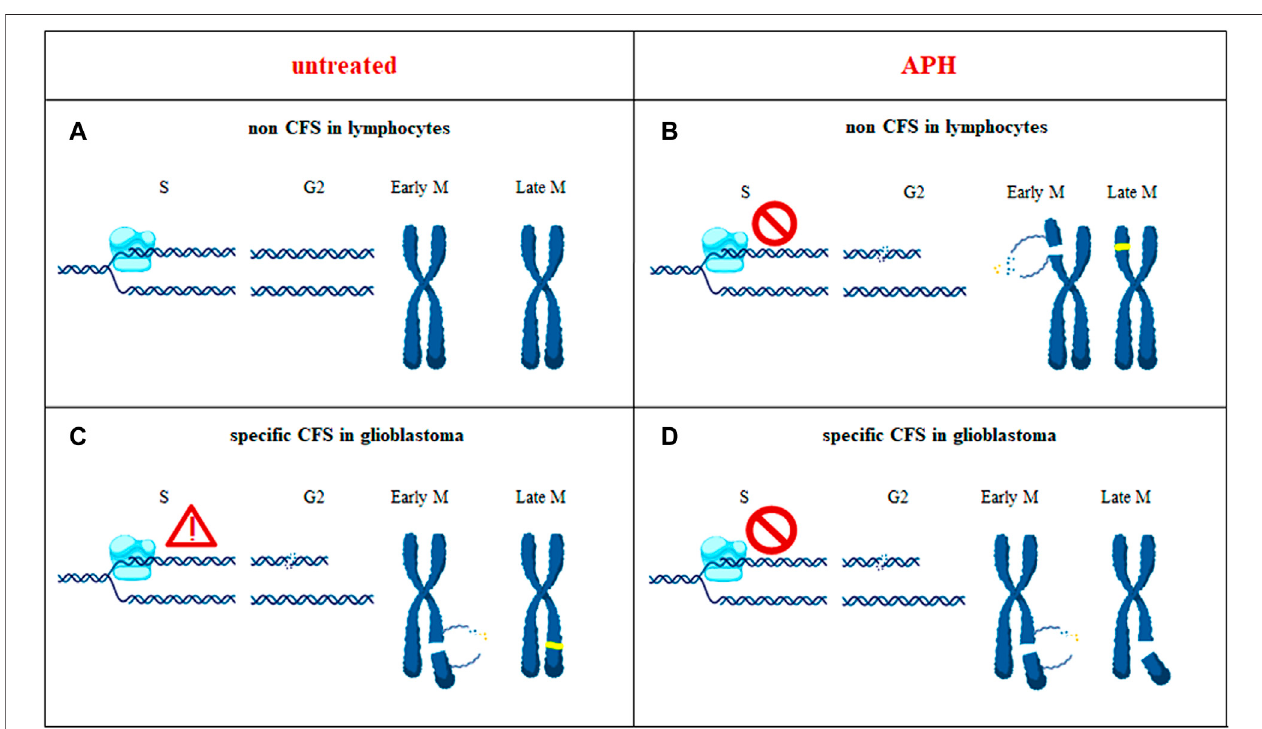
FIGURE 9 | In untransformed cells such as lymphocytes, during unperturbed cell cycle progression, a chromosome region that does not show replication issue is depicted (non CFS) (A) . In glioblastoma cells, the same chromosomal region can have an impairment that can be rescued (CFS) (C) . Under an APH-induced stressful condition, glioblastoma-CFS is unable to rescue replication impairment, hereby depicted as replication fork stalling (D) , contrary to non CFS in lymphocytes where the impairment is overcome (B) ; yellow dots are the new incorporated nucleotides during the repair processes. When the CFS burden is not dealt with, the site is expressed as a chromosome break (D)